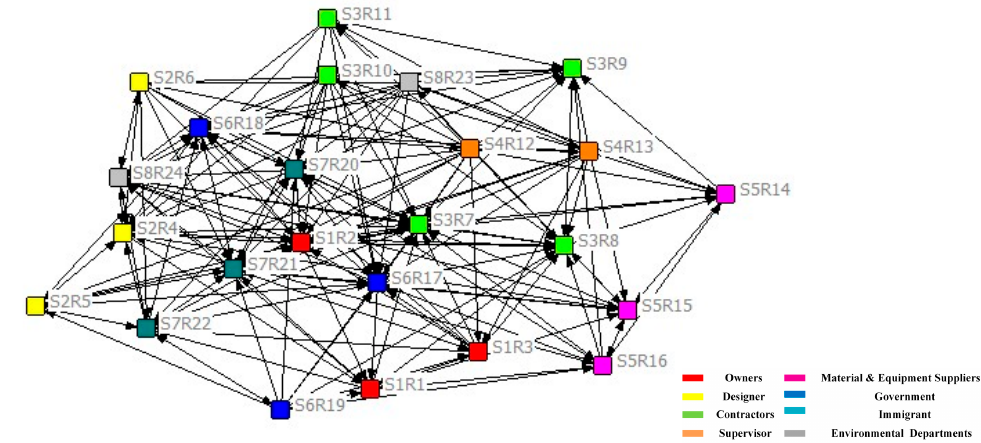
Figure 5. Behavioral risk network visualization for hydropower projects.